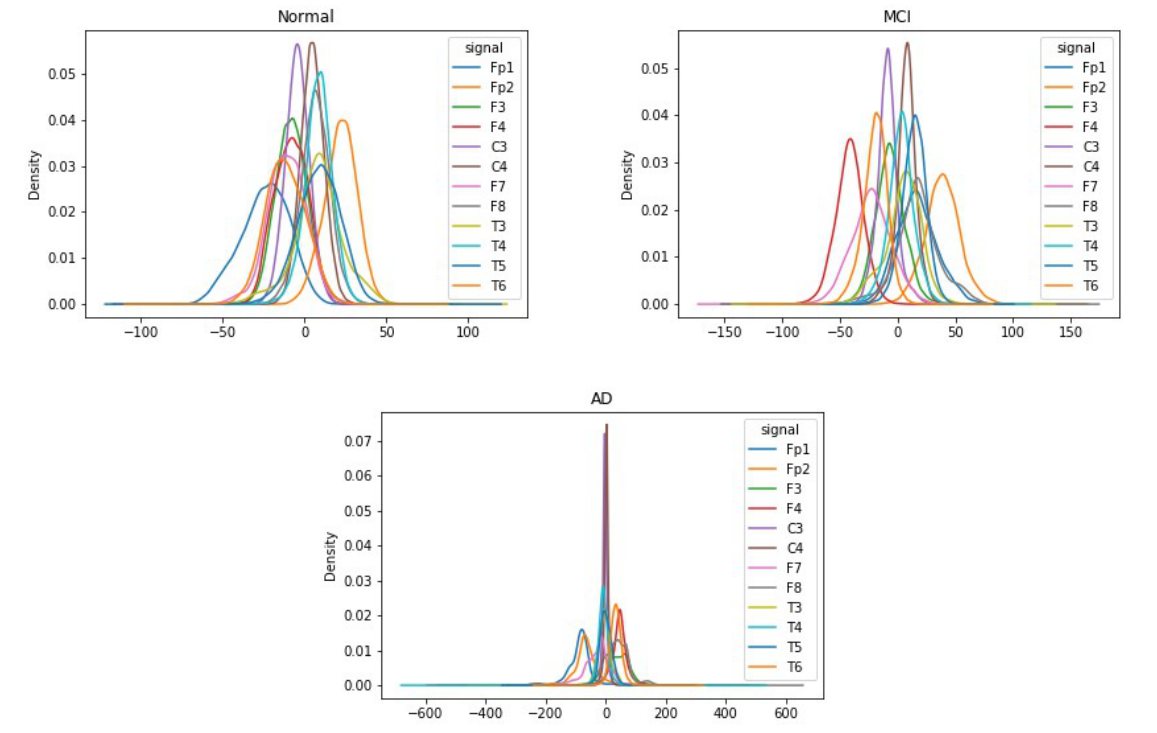
Figure A1: Indicative whole EEG Probability Density Functions for Healthy (Normal), MCI and AD